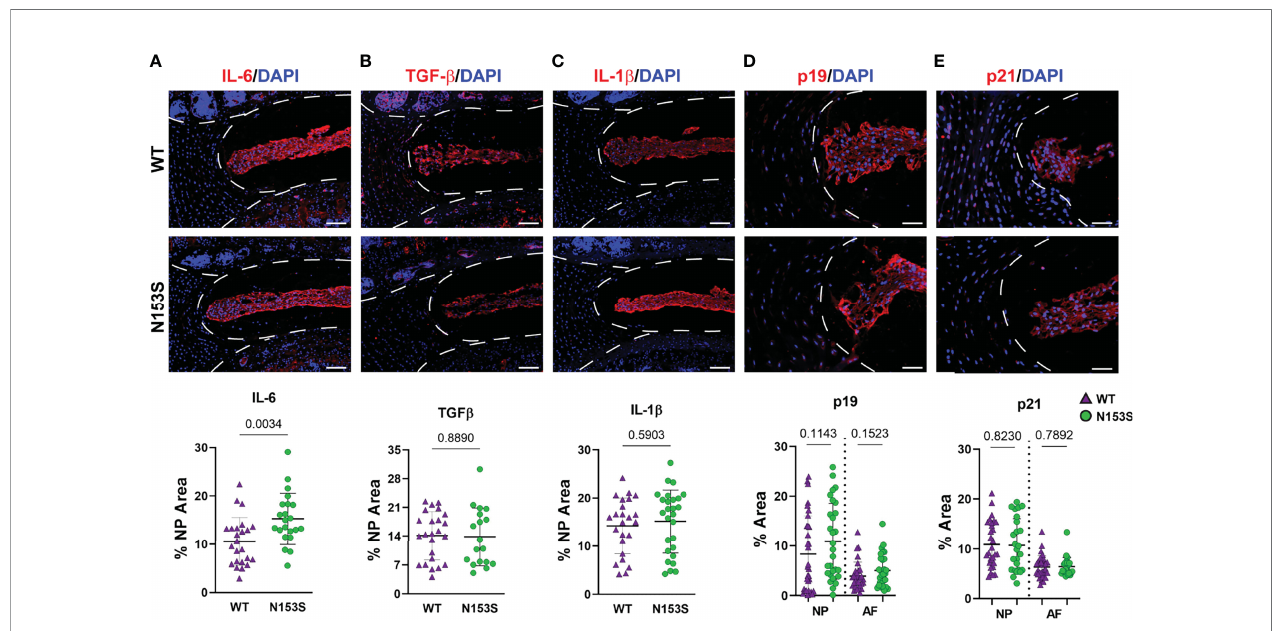
FIGURE 5 | SASP induction is not accelerated in the discs of N153S mice. Quantitative immunohistological staining conducted on 6-month-old WT and N153S lumbar discs for (A, A ’ ) IL-6, (B, B ’ ) TGF- b , (C, C ’ ) IL-1 b , (D, D ’ ) p19, and (E, E ’ ) p21. Images were taken at 10x (scale bar = 100 m m). (n = 4 discs/animal; 7 animals/genotype, 28 total discs/genotype) Dotted lines demarcate different tissue compartments within the disc. Quantitative data represents the mean ± SD. Signi fi cance was determined using unpaired t-test or Mann-Whitney test, as